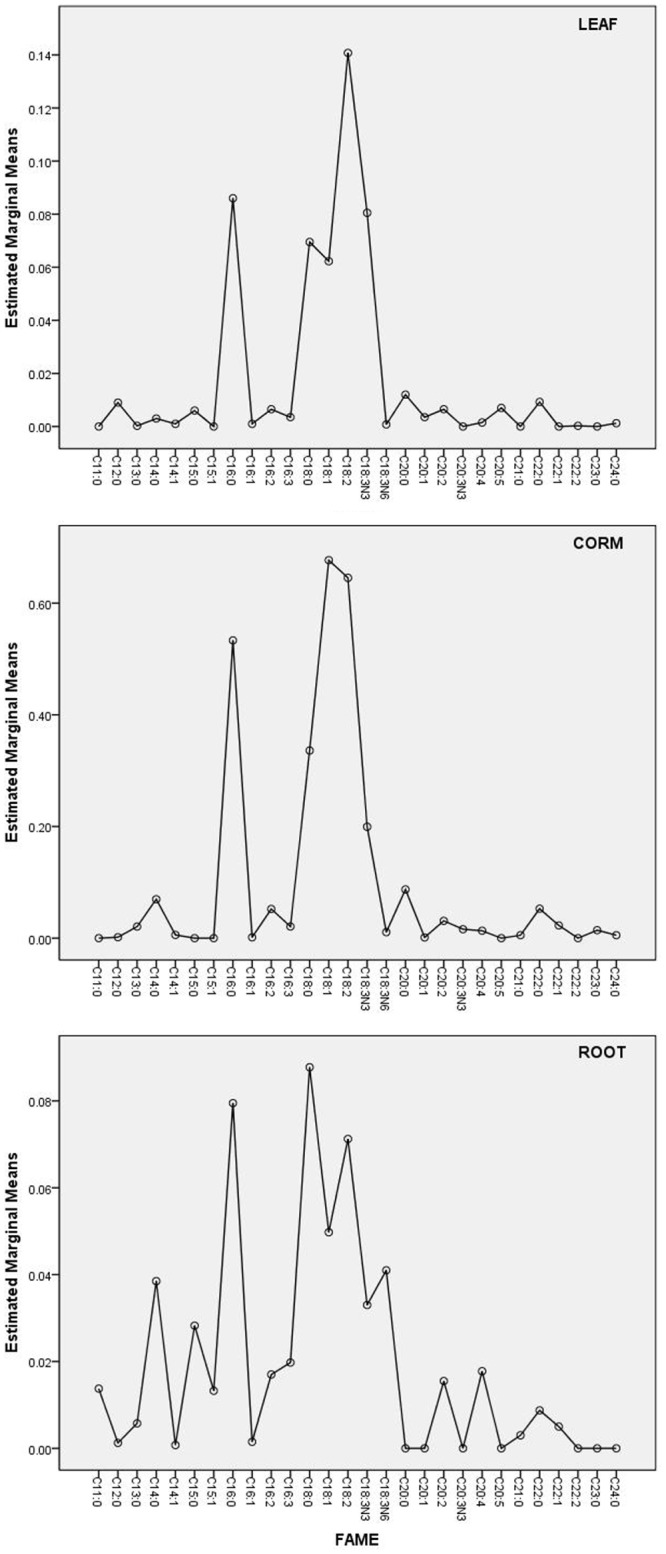
Estimated means for the content of each fatty acid in organs of Cyperus laxus.Estimated marginal means for the content of individual fatty acids in leaf, corm, and roots of Cyperus laxus based on predictions using the fitted model (Content = Soil + FAME) established from the phytoremediation treatments of soils from the oil spill-impacted sites.